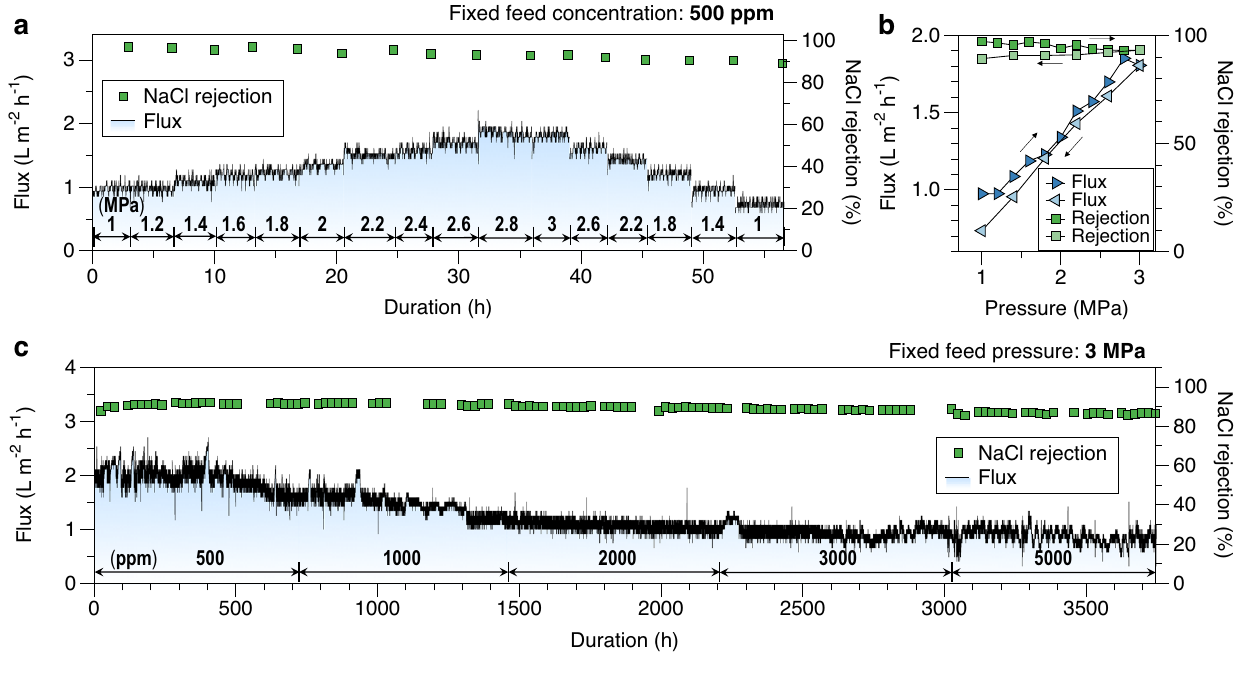
Fig. 6 | Filtration performance durability of the Glc10T60 membrane. a Filtration of 500 ppm NaCl solution with stepwise changes in the operating pressures; b Changes in fl ux and NaCl rejection during increasing and decreasing